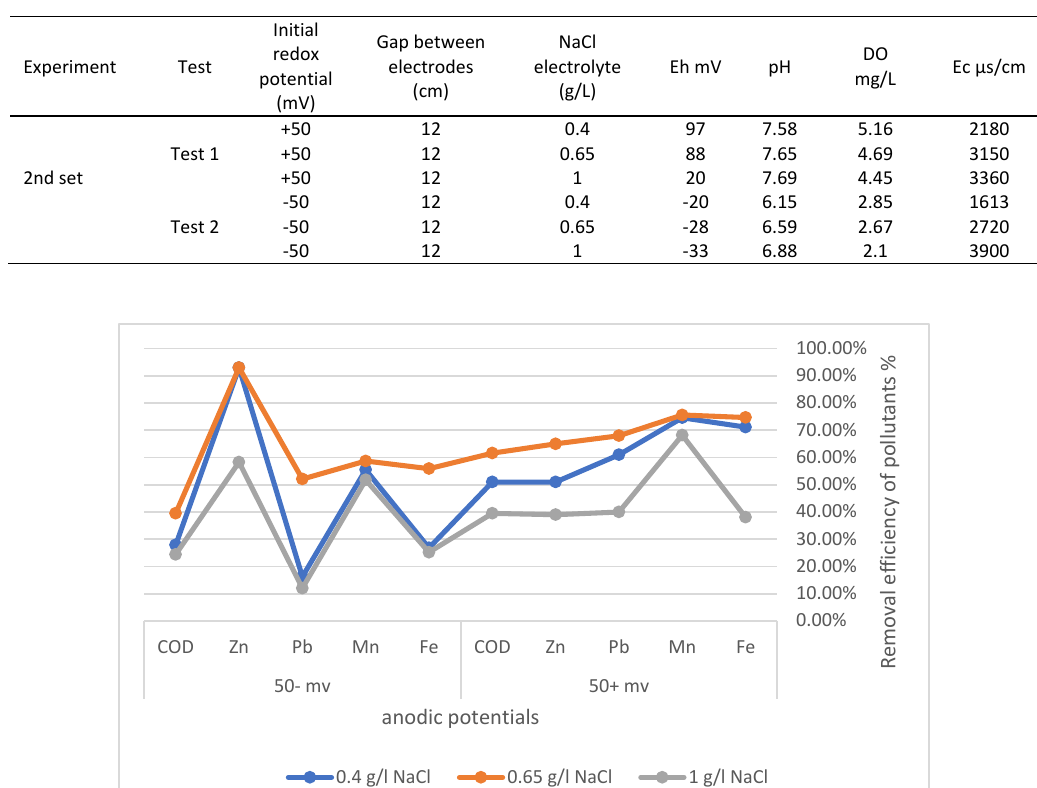
Fig. 4: Removal effectiveness of the pollutants by the PEC treatment according to the second set of analysis